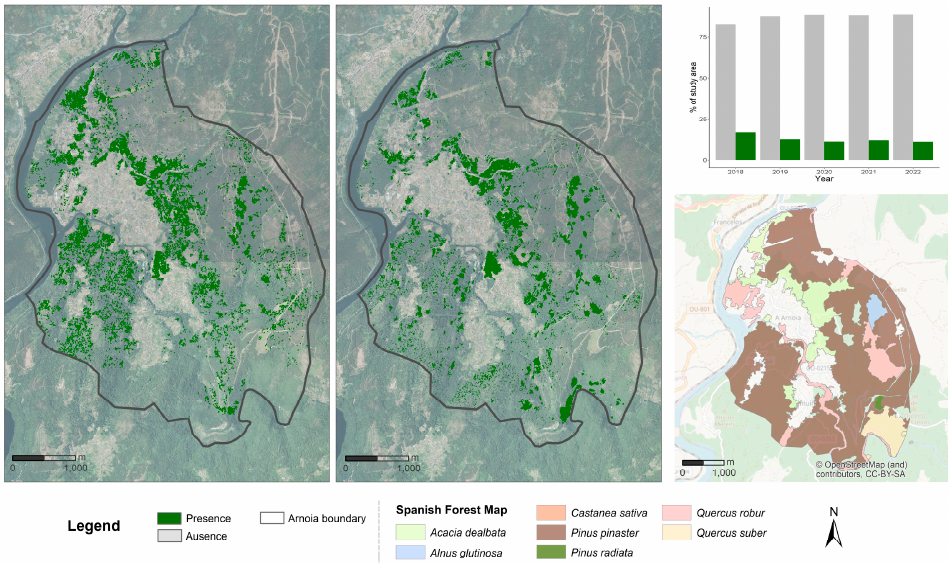
Figure 5. Acacia dealbata presence mapping using RF model for year 2018 (left) and transferred to 2022 (center) within the forested areas under study. The graph indicates the percentage of presences and absences within the study area.